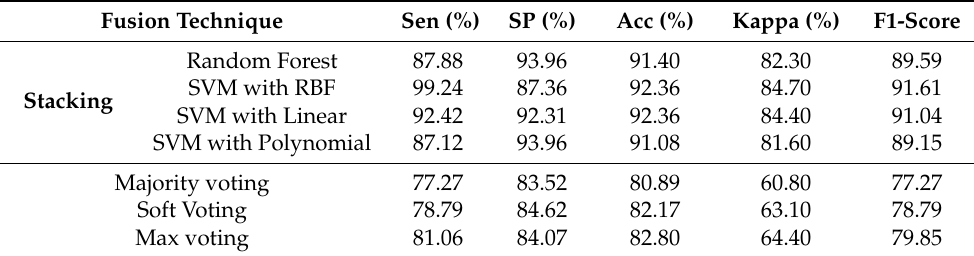
Table 7. The effect of different fusion techniques on the CBIS-DDSM